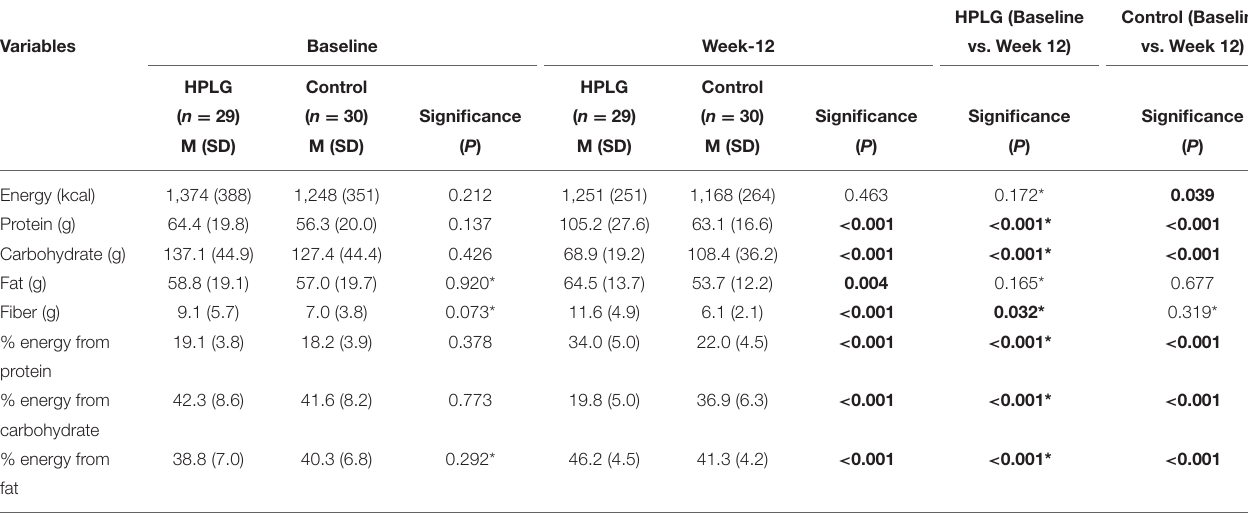
TABLE 2 | Nutrient intakes at baseline and